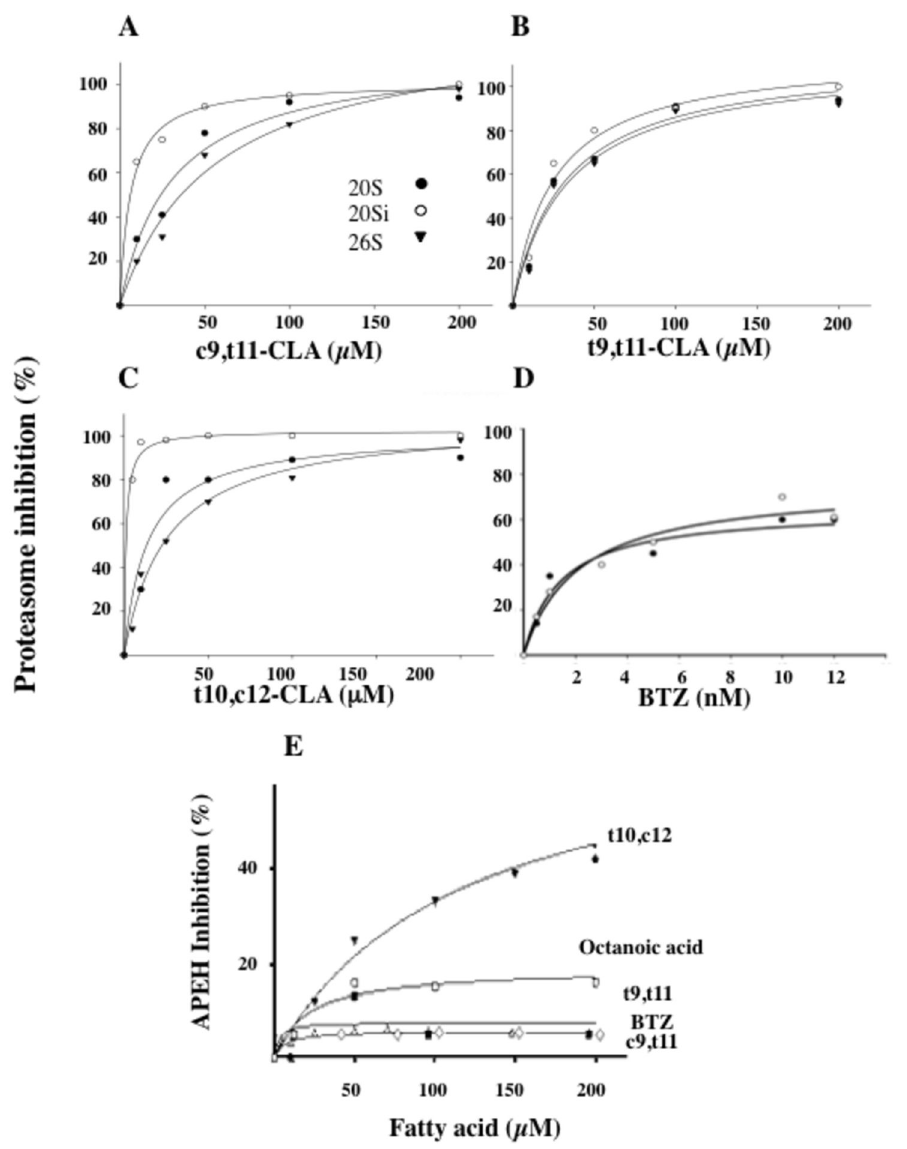
Figure 1. Fatty acids and CLA isomers exhibit dissimilar inhibitory ability towards chymotrypsin-like (CT-like) proteasome and APEH activities. The inhibitory effect of different CLA isomers, namely c9,t11- ( A ), t9,t11- ( B ), t10,c12-CLA ( C ), bortezomib, BTZ ( D ), was evaluated on commercially available pure 20S (black circles), 20Si (white circles) and 26S (black triangles) proteasomes. The synthetic fluorescent substrate N-Suc-LLVT-AMC (0.080 mM) was used for the measurement of the CT-like activity of the proteasomes. The hyperbolic curves indicate the best fits for the data obtained, with IC50 values calculated from the graphs by SigmaPlot 10.0 software. Mixtures treated with DMSO alone were used as blank. The dose-dependent inhibitory effect of c9,t11-, t9,t11-, t10,c12-CLA isomers, octanoic acid or bortezomib on APEH activity was shown ( E ). Results are presented as the mean ± standard deviation (SD) of triplicate analyses from three independent experiments. SD values lower than 5% were not shown.